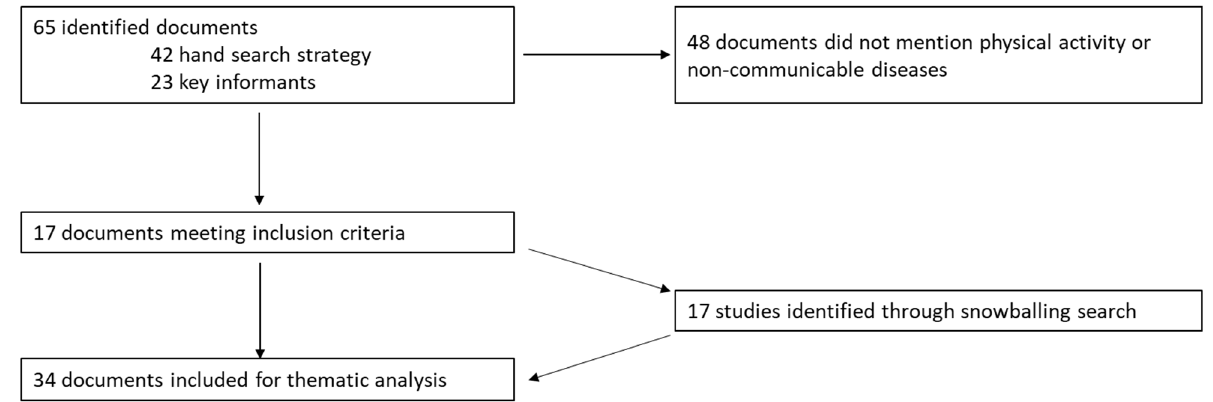
Figure 1. PRISMA flow diagram.